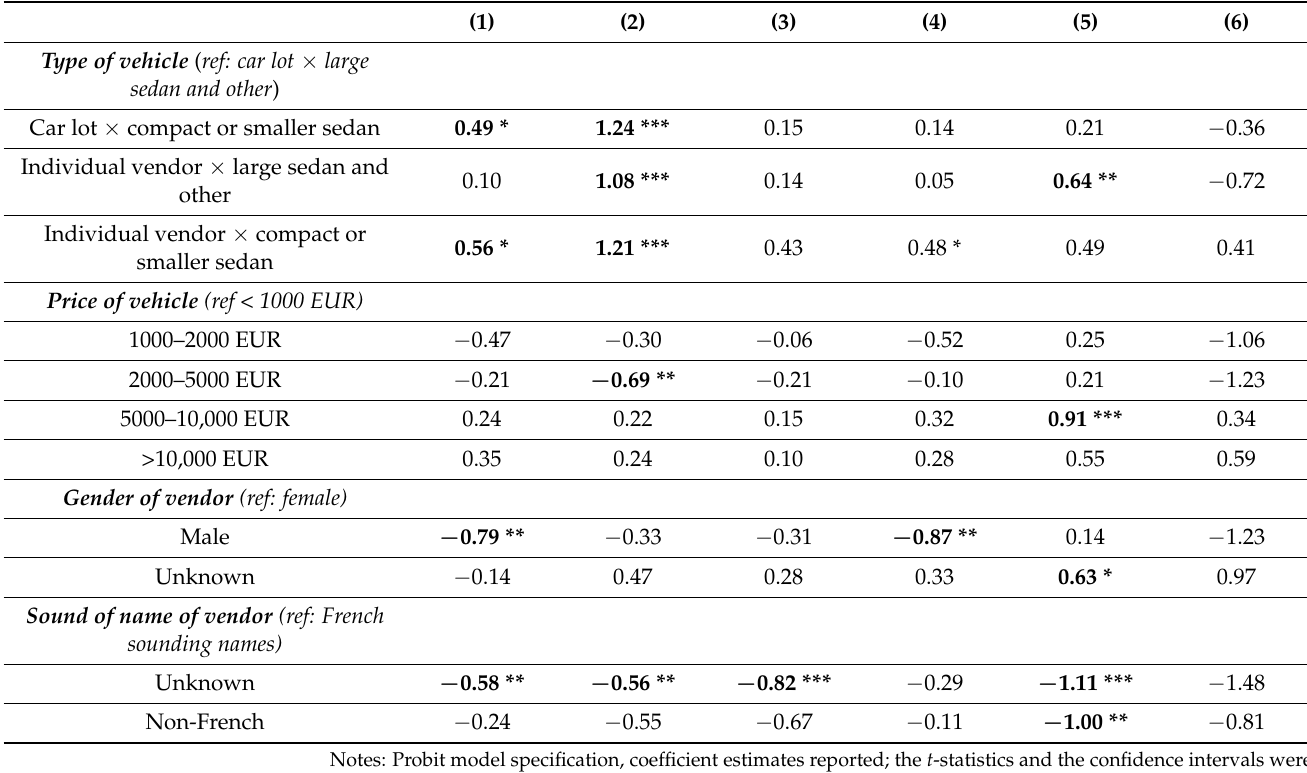
Table A3. Probit Model of the Probability of Receiving a non-negative response for each of the six fictional inquirers (coefficient estimates).